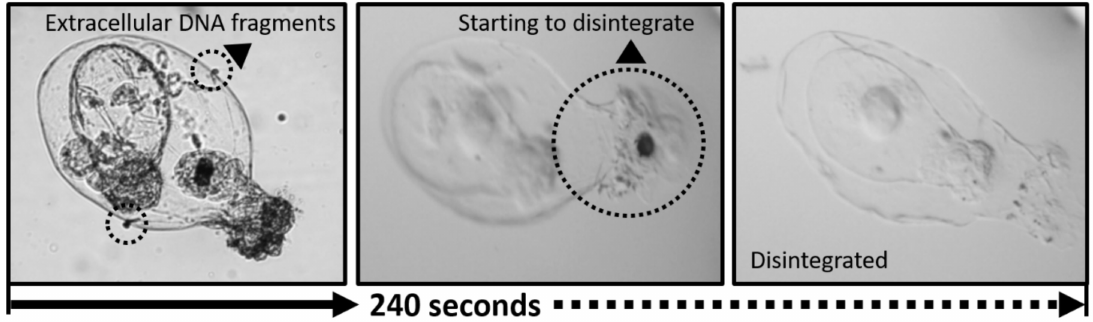
Figure 2. An example of a disintegration process; response of Asplanchna sp. lorica to commercial bleach treatment (2.5 %).